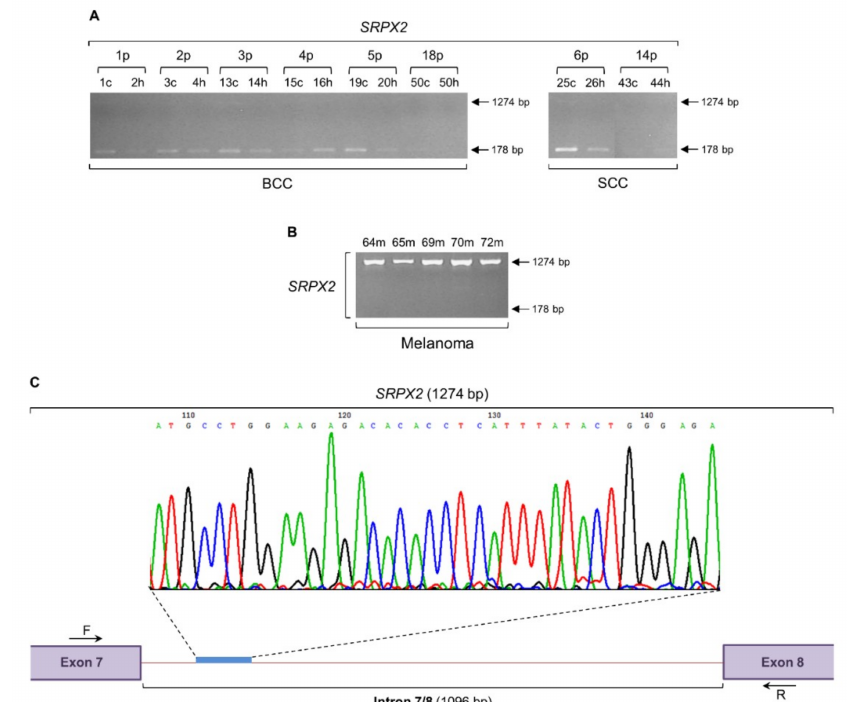
Figure 5. SRPX2 gene is subjected to a strong intron retention mechanism in melanoma, but not in non-melanoma cells. Gene expression patterns of SRPX2 , through engagement of RT-sqPCR protocols and utilization of total RNA extracts prepared from BCC and SCC ( A ) or melanoma ( B ) cDNA collections. GAPDH served as control gene (also, see Figure 6F and Table S1). ( C ) Representative DNA sequence chromatogram derived from the melanoma-specific 1274 bp long PCR product. A characteristic SRPX2 intron 7/8 (1096 bp) sequenced area is indicated. Besides intron 7/8 retention (1274 bp), note the absence of SRPX2 normal transcriptional activity (lack of 178 bp) in all